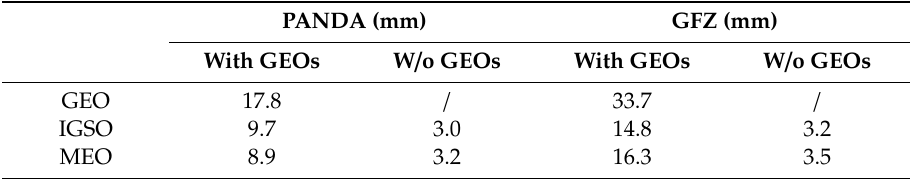
Table 4. RMS statistics of phase residuals of BDS-based POD.